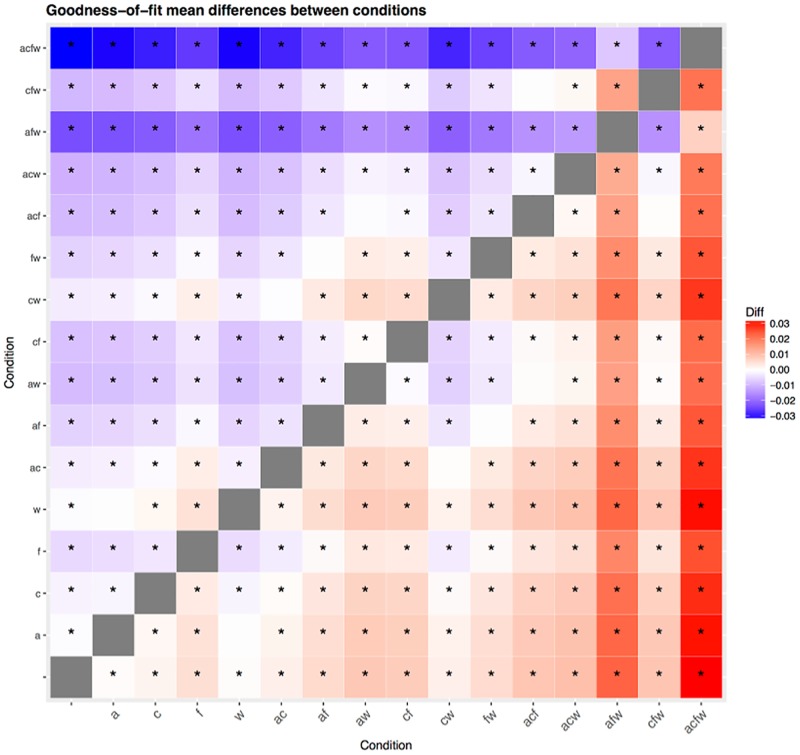
Difference in goodness of fit between conditions.This symmetric matrix represents the difference in mean goodness of fit (MSE) between all pairs of conditions (in column—row format) as color, varying between no difference (white) and maximum difference (positive red, negative blue); a star * means that the cell represents a significant difference in goodness of fit between the two conditions at the α-level of 0.01 after Tukey’s HSD posthoc testing correction.